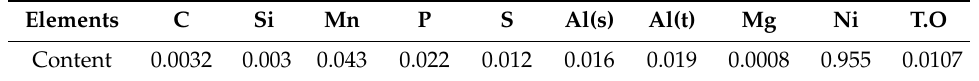
Table 2. Sample component test results (in mass percent,